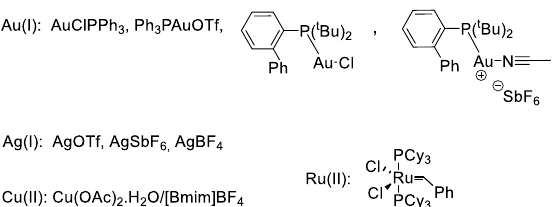
Scheme 1. Postulated catalytic cycle and reported metal catalysts for the cascade reaction between alkynoic acids and dinucleophiles.